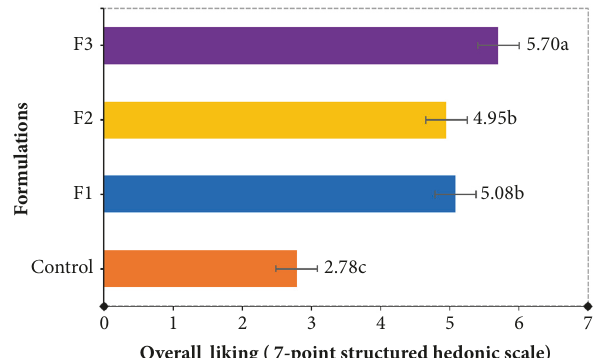
Figure 4: Average of the overall liking scores of each formulation, using a 7-point hedonic